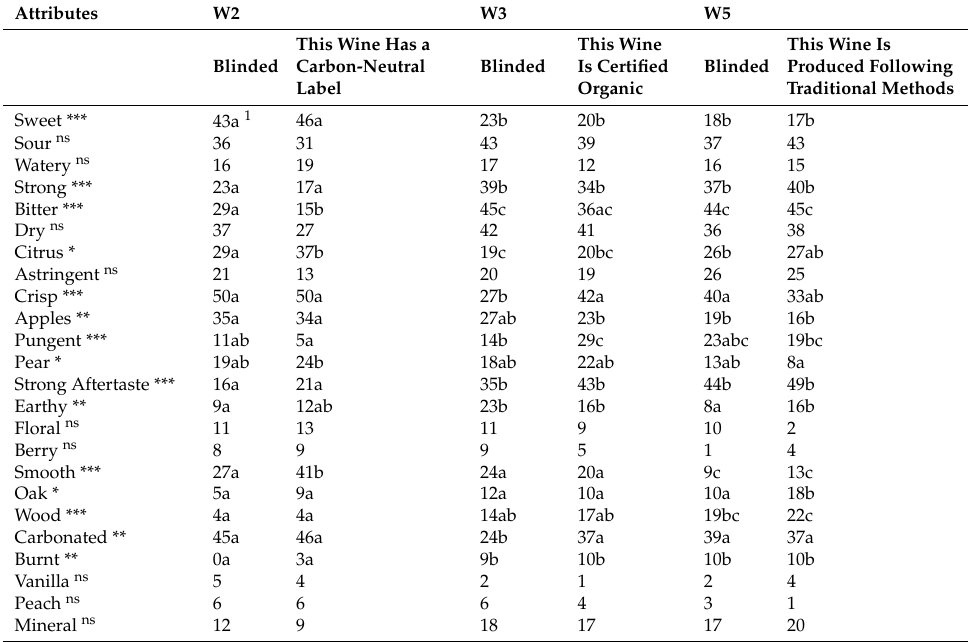
Figure 3. Penalty analysis of the CATA attributes and overall liking when the participants’ evaluated the sparkling wine evaluated blinded ( a ) and informed about the production method ( b ). Table 5. Frequency of selection of the CATA terms for the six wine samples (blinded and informed).